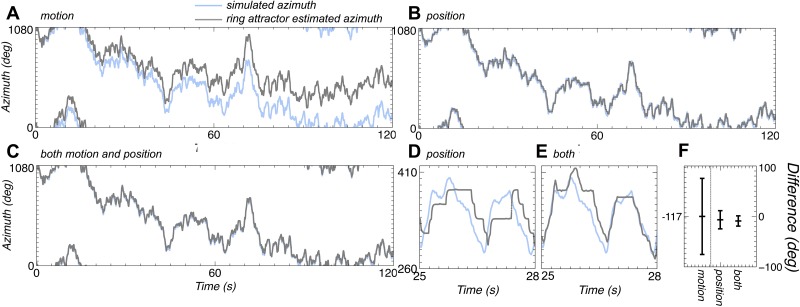
Ring attractor azimuth estimate accuracy.A shows the simulated (blue) and estimated (grey) azimuthal rotations when the ring attractor is driven only by the motion of the bar. There is overall good tracking for much of the simulation however there are time periods where the estimate drifts away from the simulated value. B show the same rotations when positional cues drive the ring attractor. There is better tracking, however D shows that the width of the receptive fields leads to a stepped profile for the ring attractor estimate as movement of the bar within a receptive field cannot be detected. C shows the same rotations with combined position and motion driving the ring attractor. There is good tracking, and E shows that the motion signal can compensate for the insensitivity of the motion system within a receptive field. F summarises the results showing that the circular mean and standard deviation (calculated using the Matlab Circular Statistics Toolbox [38]) of the difference between the simulated and estimated rotations is largest with motion only driving the ring attractor and smallest with combined motion and position.